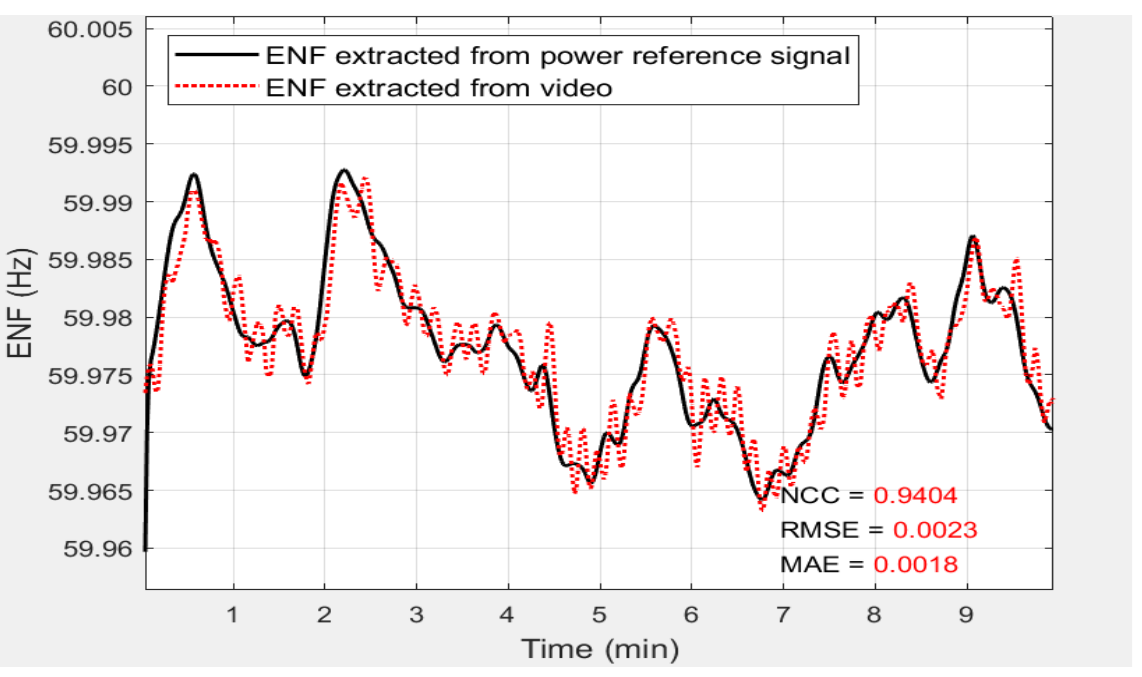
Figure 5. Sample of the ENF signal extracted from a video file (red) using a 𝑇 𝑟𝑜 value of 19.8 ms (iPhone 6s) and matched against the reference signal (black). The bottom right corner shows the measure of similarity and dissimilarity between the extracted signal and the reference signal.